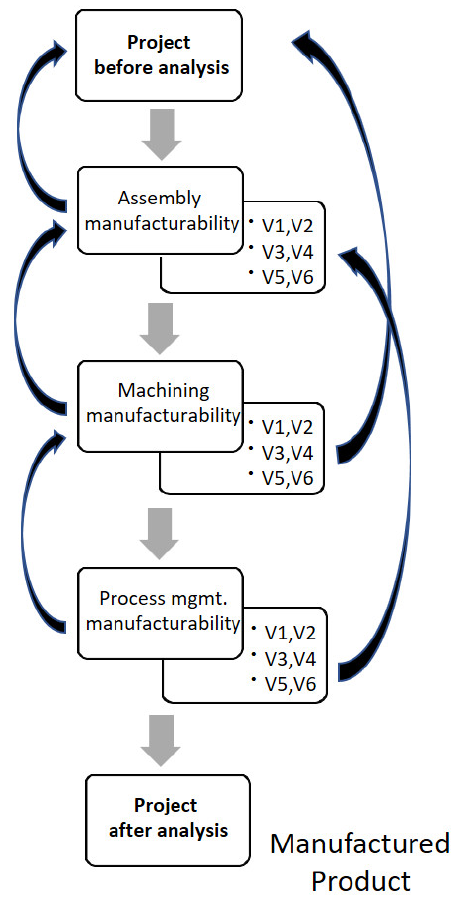
Figure 2. Structural analysis of the structure’s technology in the proposed method.